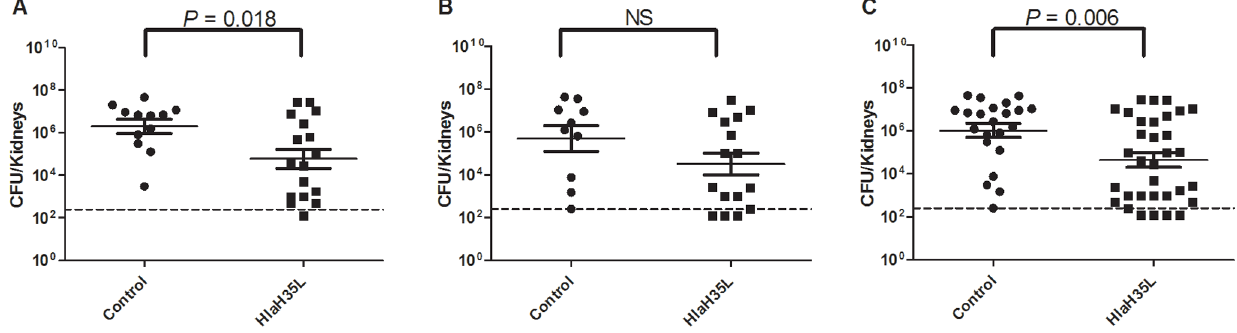
N Figure 3. Analysis of HlaH35L in a systemic infection model of S.aureus infection. Control animals receiving aluminum hydroxide/CpG ) and animals receiving HlaH35L with adjuvant ( & ) were compared in an IV challenge model with 3 6 10 6 CFU SAP149 as the challenge adjuvant ( dose. Shown are the data for two individual experiments performed identically (A and B) and the combined data (C). The CFU per pair of kidneys are plotted, with the mean + / 2 SEM indicated for each group and the P value determined by two-tailed Student’s t-test. The dashed line indicates the limit of detection. doi:10.1371/journal.pone.0063040.g003 PLOS ONE |